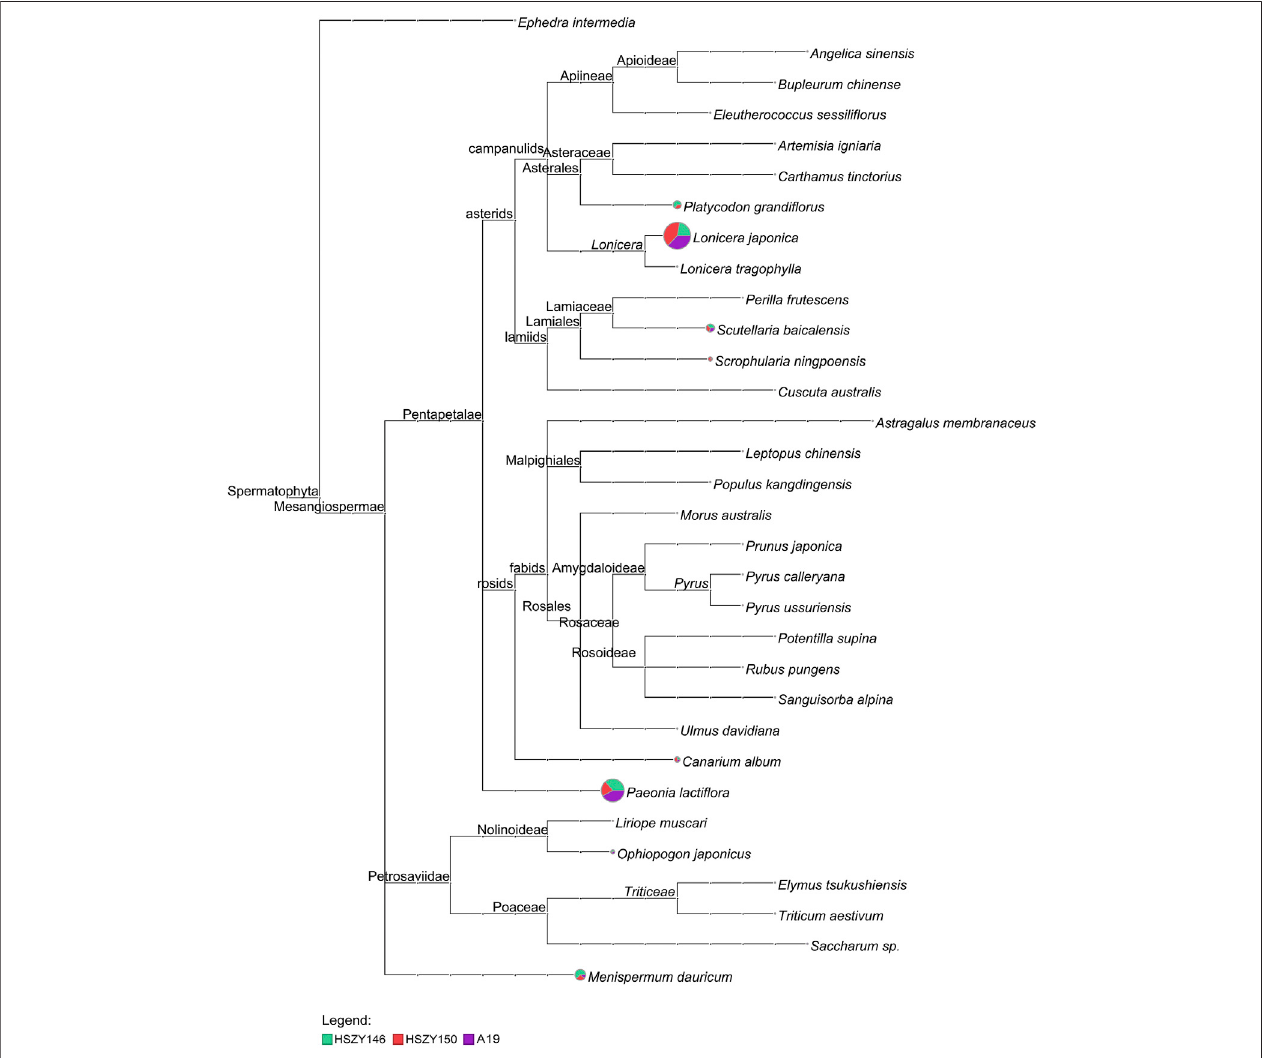
FIGURE 3 | MEGAN6 analysis result for the three samples detected by reads belonging to ITS2 against the NCBI-NT and TCM-BOL database. Each taxonomic node is drawn as a pie chart indicating the proportion of each species in the taxon for each sample.